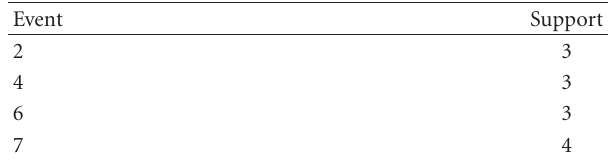
Table 4: Large event set.